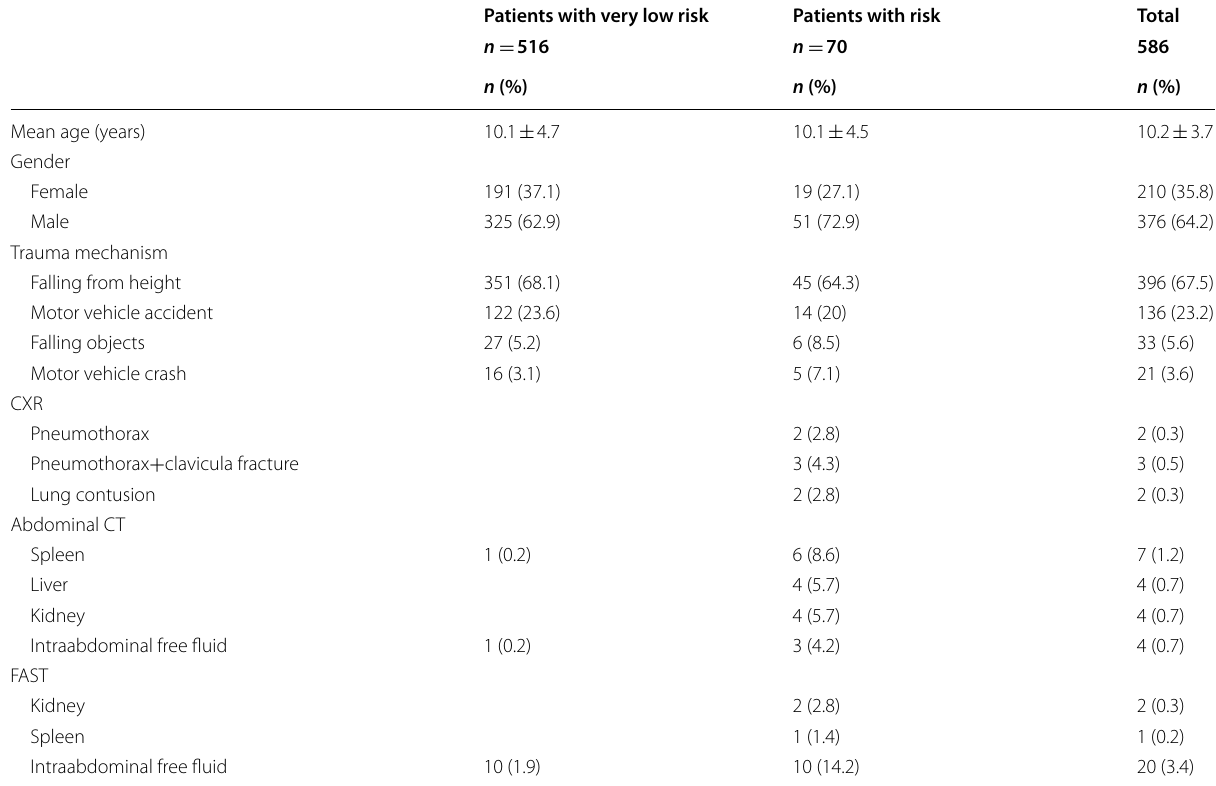
CXR chest x-ray, CT computed tomography, FAST focused assessment with sonography for trauma